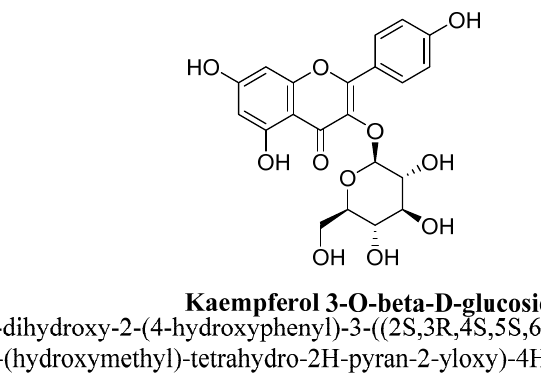
Figure 24. Kaempferol-3-O-beta-D-glucoside. Myricetin is a hexahydroxyflavone and substituted with hydroxyl group at C3, C3 ′ , C4 ′ , C5, C5 ′ and C7 (Figure 25). It is highly abundant in fruits, vegetables, nuts, red wine, berries, and tea. It has been documented for anti-inflammatory, antioxidant, neuroprotective and anti-apoptotic properties [102,103]. In a study, myricetin has found to decreased depressive behavior in mice when exposed to stress, which was predicting in forced swim and tail suspension test. This flavonol has found to decreased plasma level of corticosterone, improved activity of glutathione peroxidase enzyme in hippocampus and also increased BDNF level, all these results contributed to anti-depressant potential of myricetin [104].